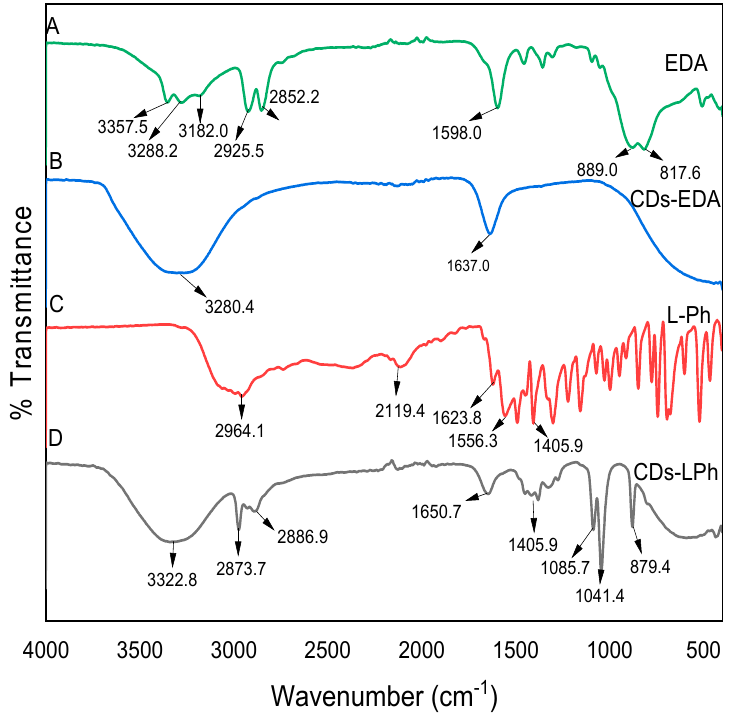
Figure 9. FTIR spectra of ( A ) EDA ( B ) CDs-EDA ( C ) L-Ph ( D ) CDs-LPh.